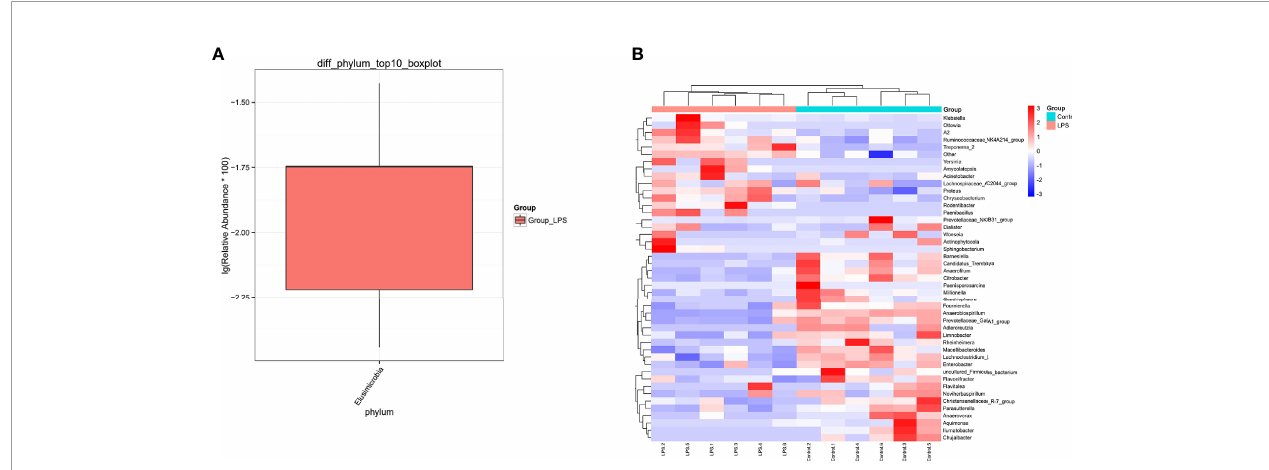
FIGURE 4 | Differential species of the intestinal microbiota of mice in the LPS group and control group. (A) The phylum level is evident from the box drawing. (B) The genus level is represented by a heat map. Orange indicates relatively high species abundance, while blue indicates relatively low species